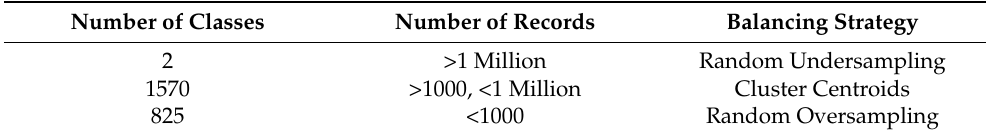
Table 3. Balancing strategy.